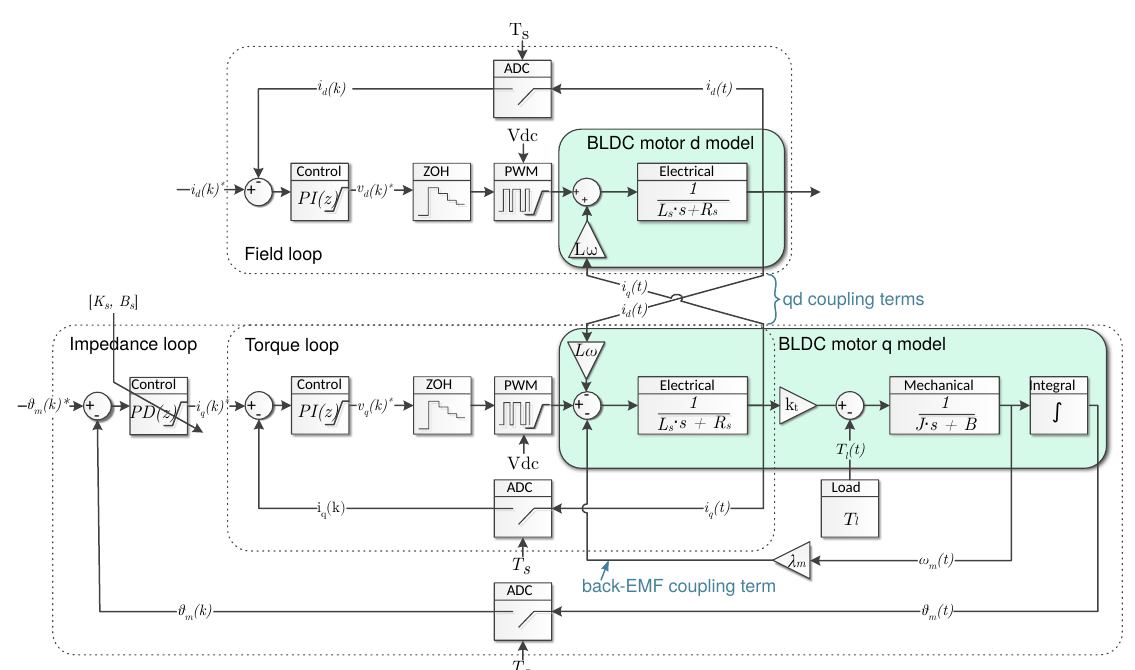
Figure 3. Simplified block diagram illustrating the rotating reference frame equivalents of the Field, Torque and Impedance